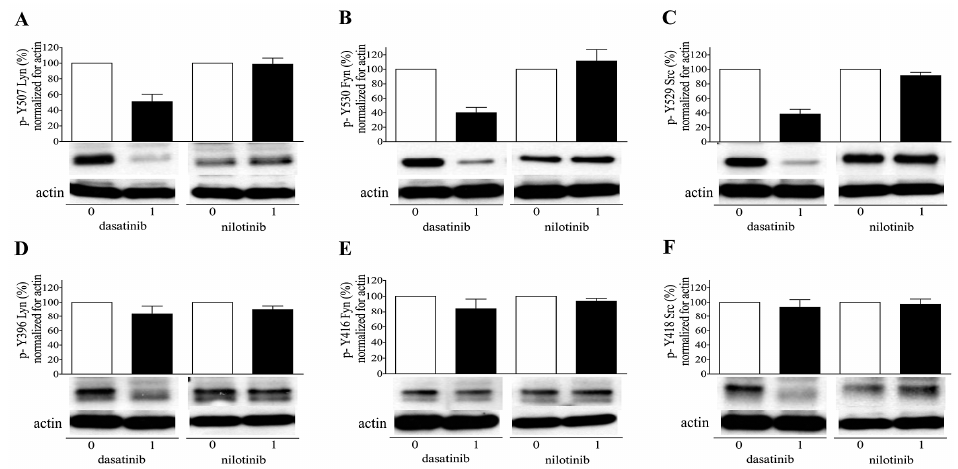
Figure 6. Dasatinib inhibits the phosphorylation of C-terminal tail and activation loop of Sarcoma family kinases (SFK) in CML patients. Lysates of platelets from dasatinib ( n = 3) or nilotinib ( n = 3) treated patients were examined with the indicated antibodies against the inhibitory ( A – C ) and the full activatory ( D – F ) phosphorylation of Lyn, Fyn, and Src kinases. The quantity of phosphorylated SFKs in platelet lysates before drug administration (0) was regarded as 100 %. Columns show the mean and SEM.